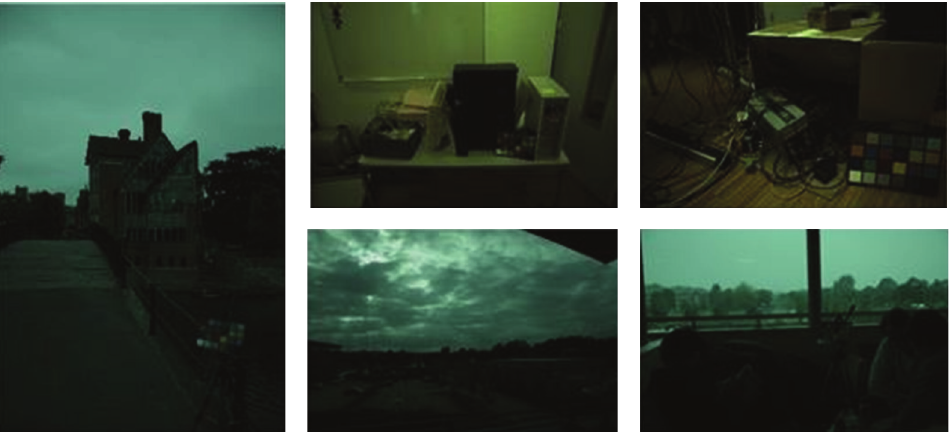
Figure 4: Original image (without AWB) captured by Canon SLR camera.